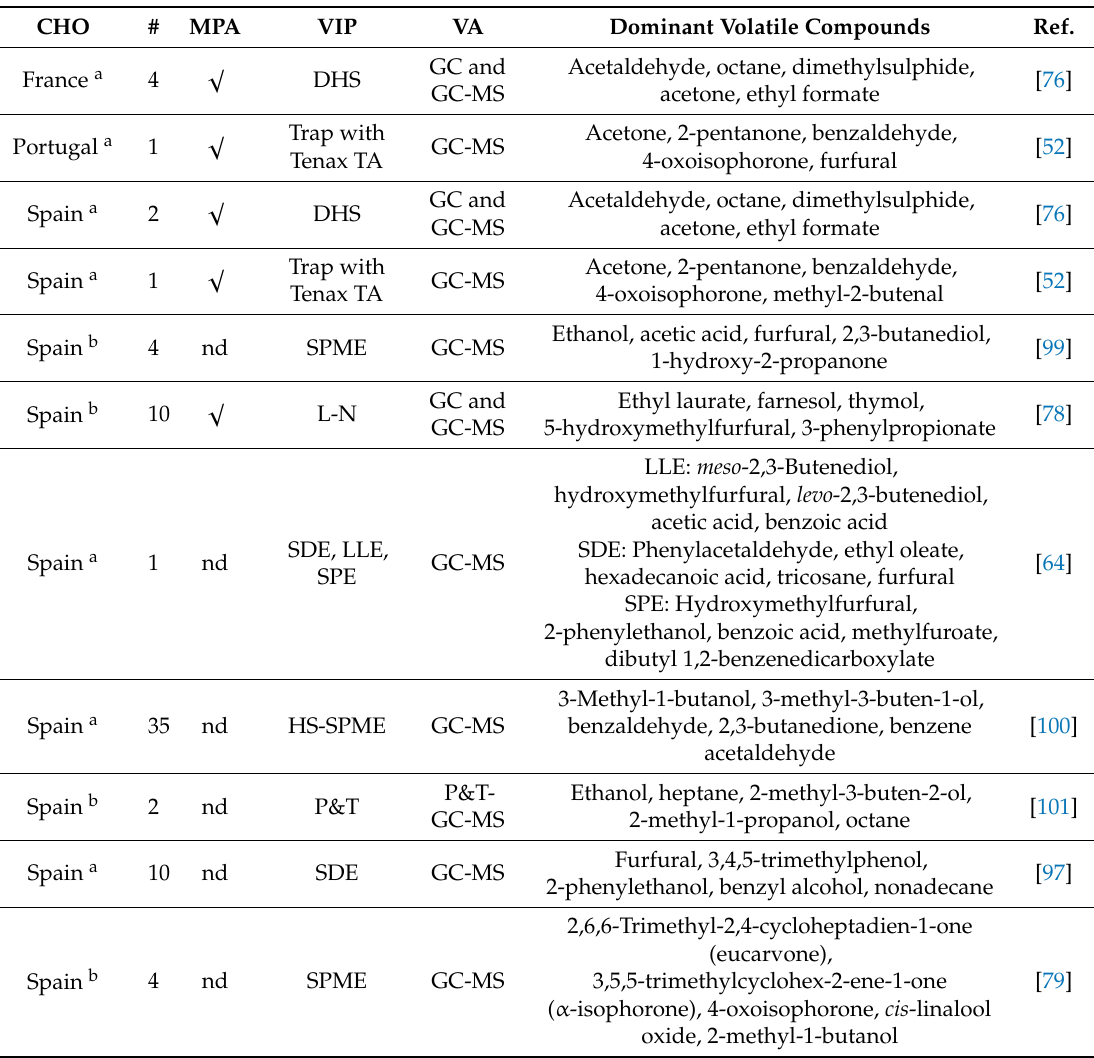
Table 18. Rosemary honey’s main volatiles, with reference to the country of origin, number of samples, isolation and analysis procedures and five main volatile components. Unless otherwise specified, the honeybee type was A. mellifera .